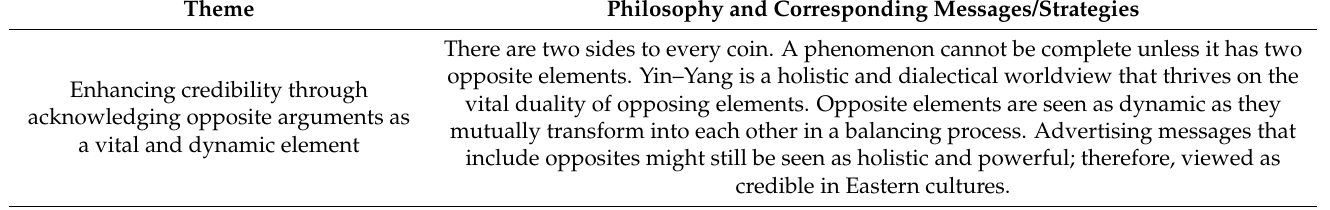
Table 1. Applying Yin-Yang perspective for two-sided